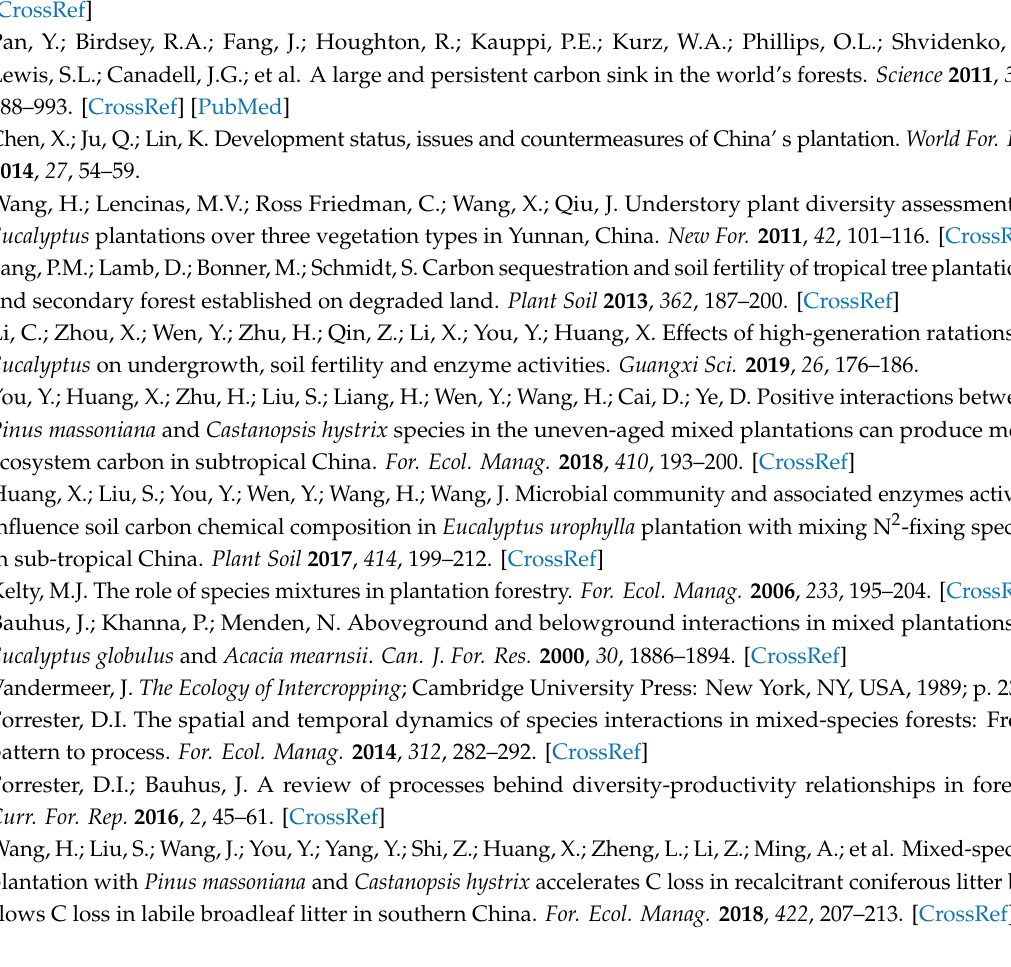
Table S1: E ff ects of stand type, season and their interactions on stand biomass, Table S2: E ff ects of stand type, season and their interactions on soil microbial structure, Table S3: E ff ects of stand type, season and their interactions on relative abundance of the soil microbial community PLFAs, Table S4: E ff ects of stand type, season and their interactions on soil enzyme activity, Table S5: Marginal and conditional e ff ects of biotic and abiotic factors on soil microbial composition obtained from the summary of forward selection in Redundancy analysis (RDA), Table S6: Marginal and conditional e ff ects of soil microbial functional groups on soil enzyme activity and soil microbial carbon source utilization ability obtained from the summary of forward selection in Redundancy analysis